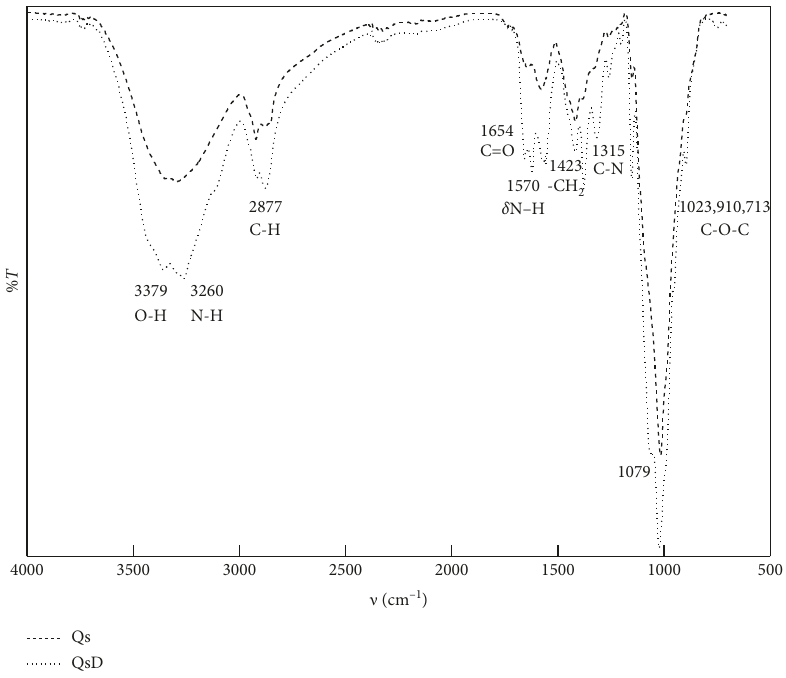
Figure 5: FTIR spectrum of Qs and QsD; in both, there exist the characteristic groups.